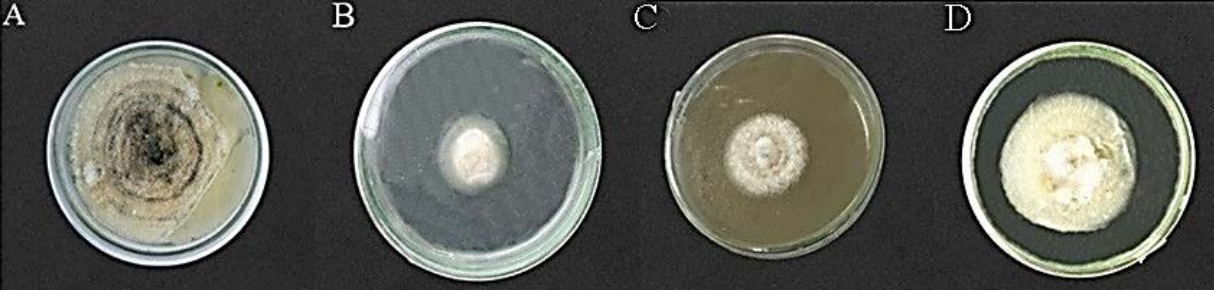
Figure 11. In vitro antifungal activity of MB-ZnO nanocomposite. C (control), T1 (6 mg/mL), T2 (12 mg/mL), and T3 (19 mg/mL). 4. Conclusions In conclusion, it can be confirmed that R. oryzae is the disease-causing pathogen of the leaf spots on Kiwi. This is a novel study of R. oryzae causing leaf spot disease in Kiwi in Pakistan. In the present work, MB-ZnO was efficiently synthesized through an eco- friendly and price-effective procedure systematically elucidated above. The physicochem- ical characteristics were also investigated via different microscopic and spectroscopic techniques. The small size and different functional groups of the MB-ZnO nanocomposite were confirmed through FTIR and XRD studies and declared as effective antimicrobial agents. The XRD results showed that the ball-milled synthesized nanocomposite was in a crystalline shape, such as chemically synthesized pure ZnO. SEM and EDX results also